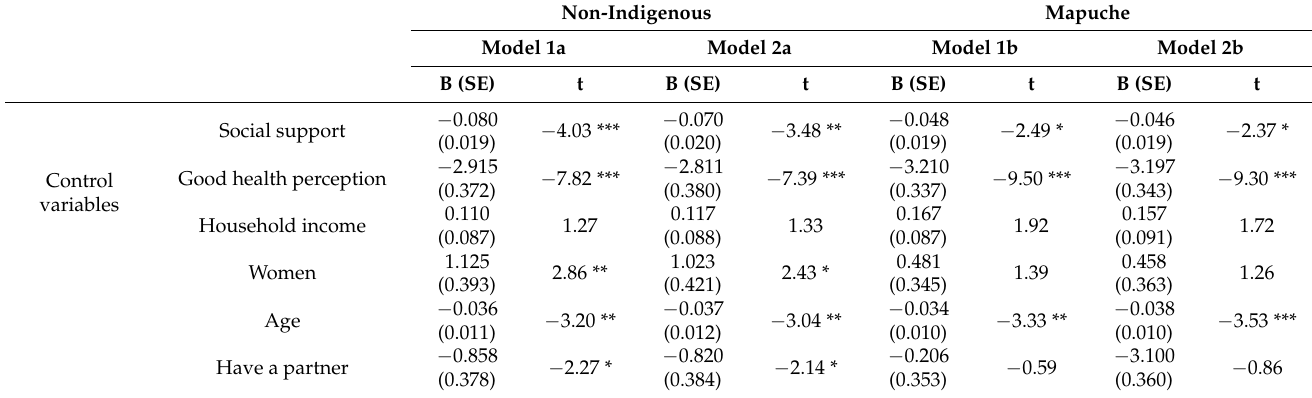
Table 2. Linear regression models. Dependent variable depression